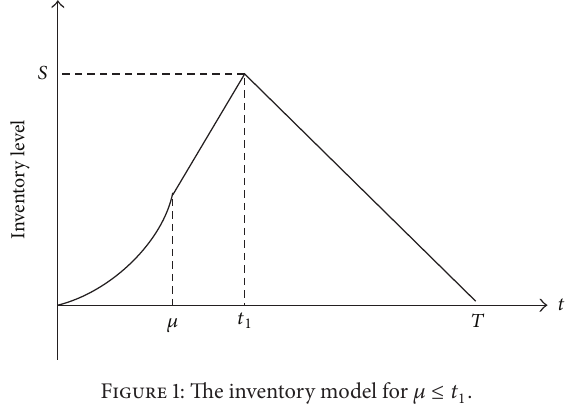
Figure 1: The inventory model for 𝜇 ≤ 𝑡 1 .